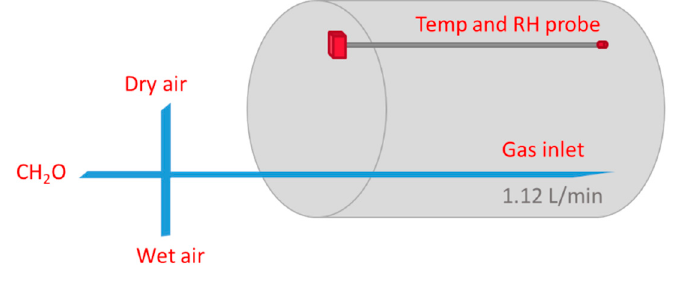
Chemosensors 2020 , 8 , 8 Figure 1. Schematic of the chamber gas flow. Legend: RH, relative humidity. Figure 1. Schematic of the chamber gas flow. Legend: RH, relative humidity.